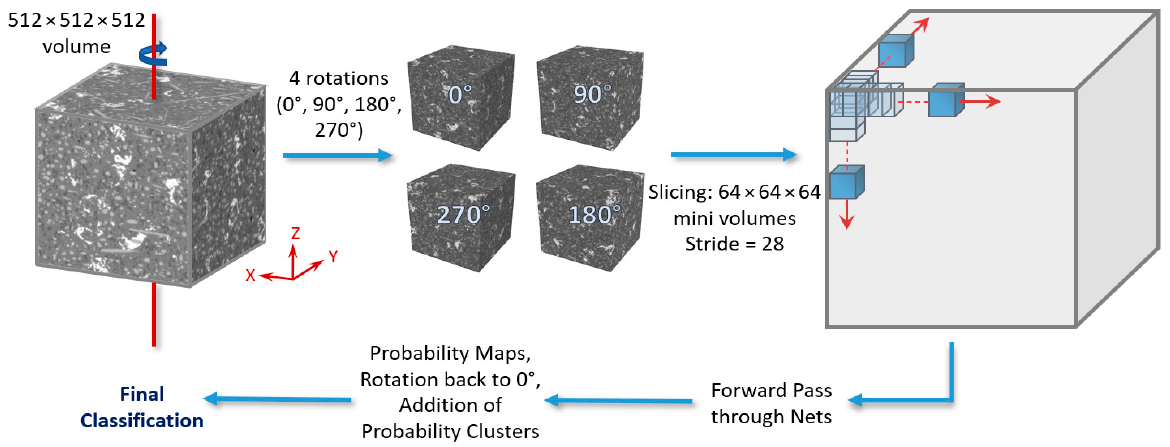
Figure 6. The MultiView forwarding strategy (for a detailed description, please refer to the text).